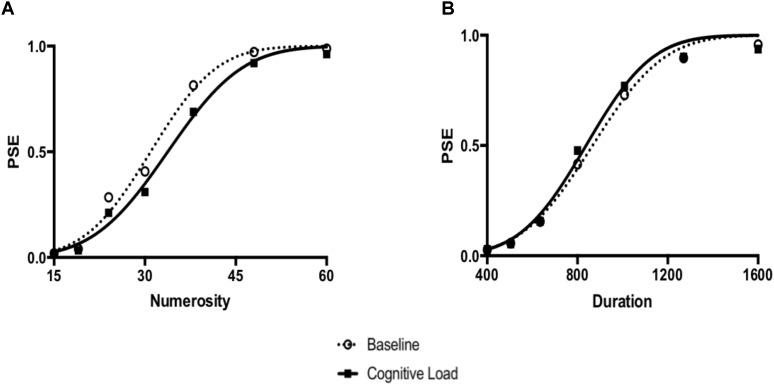
(A) Numerical bisection data and the best fitting Cumulative Gaussian functions using the group average. (B) Temporal bisection data and best fitting Cumulative Gaussian functions using the group average.